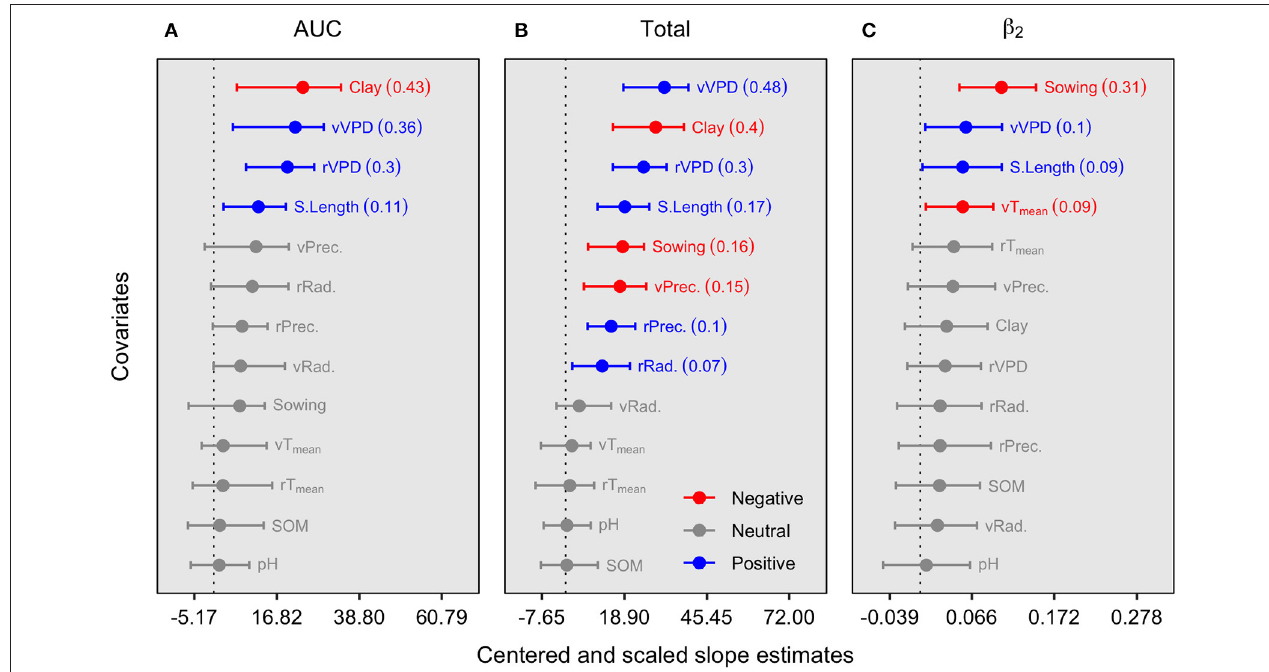
FIGURE 2 | Slope magnitude and 95% credible intervals for center-scaled environmental descriptors of the AUC (A) , total fixed-N at maturity (B) , and time of maximum growth (ß2) (C) . The value within parentheses represents the r 2 median for the respective regression. Significant slopes, either positive or negative, were determined by the 95% credible intervals. Further details on these variables and their units are presented in Table 2 . Temp, temperature; tSL, total season length; Prec, precipitation; Rad, radiation; lat, latitude; DOY, day of the year; SOM, soil organic matter; r, reproductive period (R1–R7); v, vegetative period (VE-R1, excluding